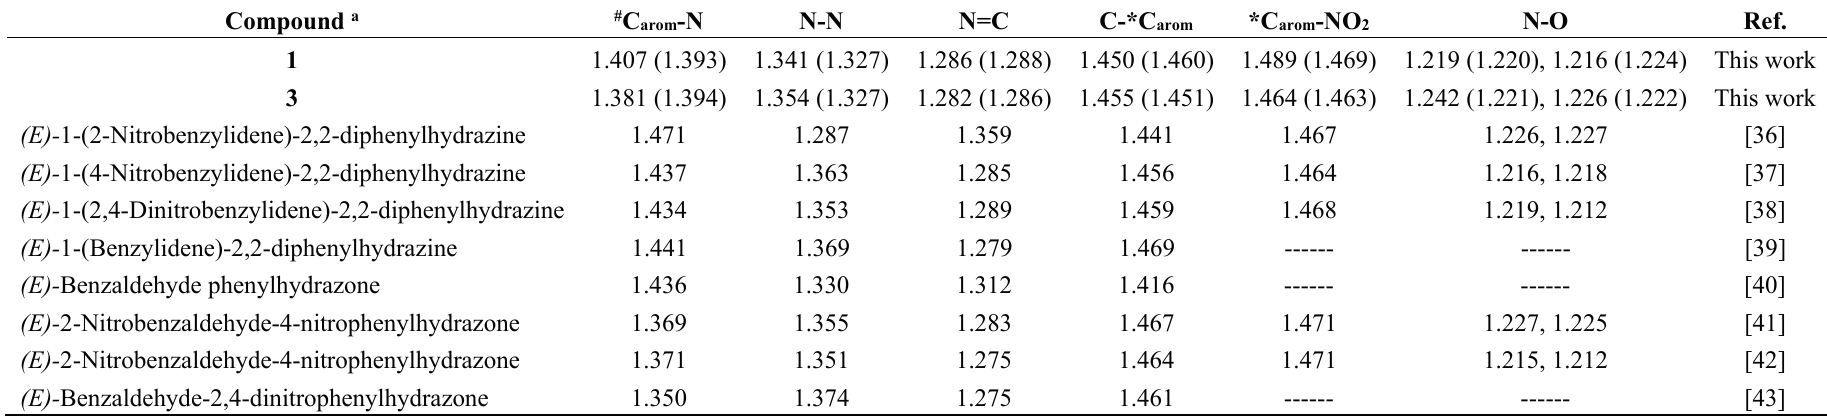
Table 3. Selected bond length (Å) and angles (°) for compounds 1 , 3 and similar compounds found in literature. Distances from the DFT calculations are shown in